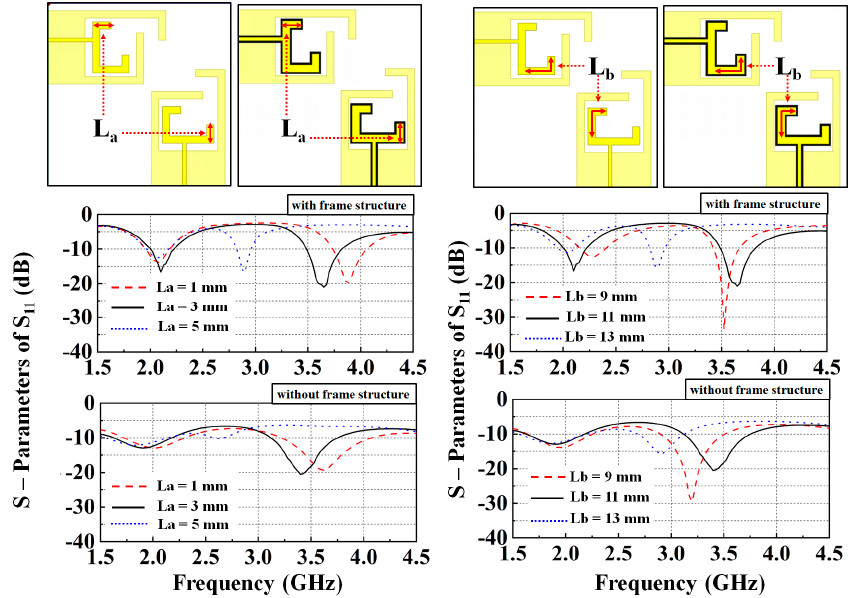
Figure 5. Measured (solid line) and simulated (dash line) S − parameters of the dual − band transpar- ent antenna.